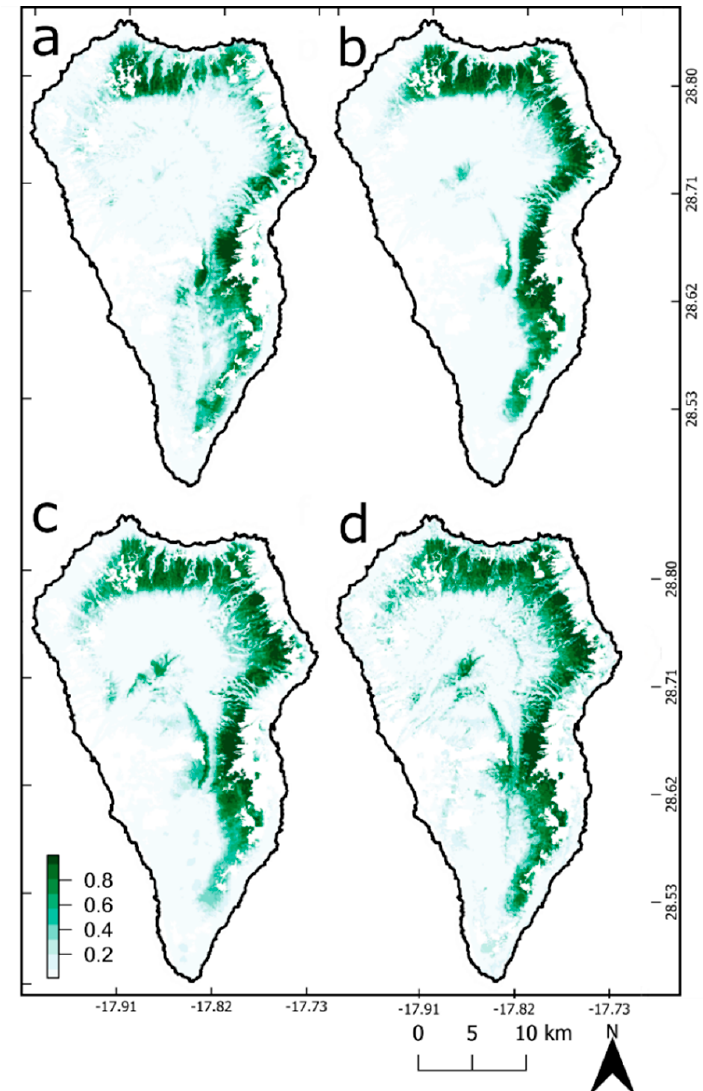
Figure A5. C. sativa habitat suitability maps ( a ) from the Random Forest (RF) field-collected species occurrence locations, ( b ) from the (RF) based on the remote sensing (RS) species occurrence locations, ( c ) from the Generalized Additive Linear Model (GAM) based on the RS species occurrence locations and ( d ) from the Maximum Entropy (MaxEnt) Model based on the RS species occurrence locations.